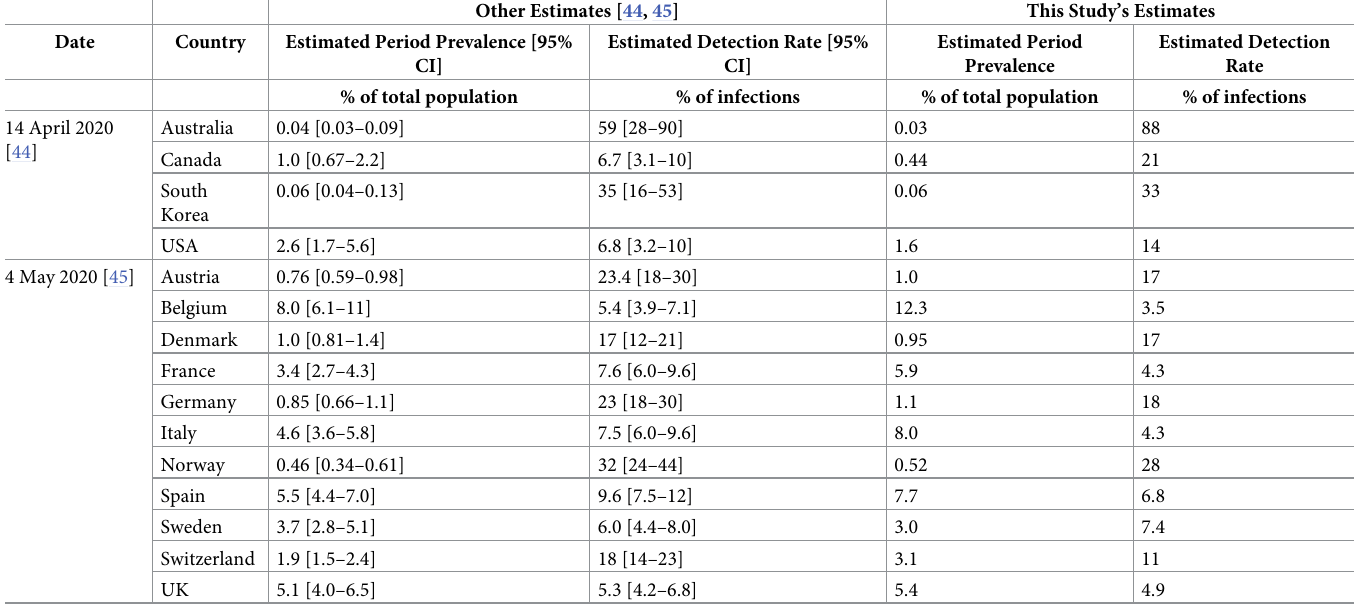
Table 2. Comparison of period prevalence and detection rate estimates with other similar estimates in literature [44, 45]. Other Estimates [44, 45] This Study’s